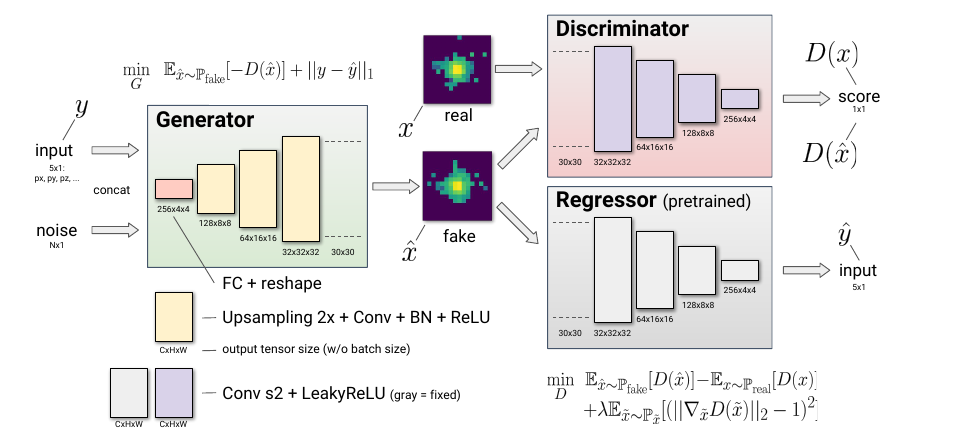
Figure 1: Model architecture. Pre-trained regressor for the particle parameters prediction makes our model conditional. Thanks to building up the information from the pre-trained re- gressor into the discriminator gradient we learn G to produce a specific calorimeter response. Loss functions for generator and discriminator are also presented.